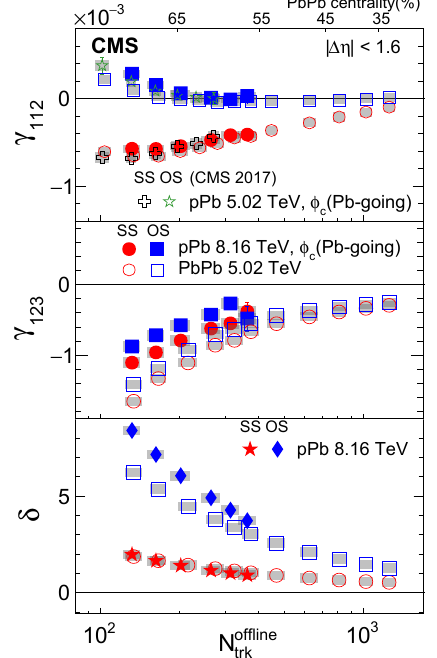
Figure 2. The SS and OS three-particle correlators, γ 112 (upper) and γ 123 (middle), and two-particle correlator, δ (lower), averaged over < 1 . 6 as a function of N o ffl ine ∆ η = 8 . 16 TeV and PbPb in pPb collisions at √ s trk NN | | collisions at 5.02 TeV [14]. The SS and OS two-particle correlators are denoted by di ff erent markers for pPb collisions. The results of γ 112 for pPb collisions at 5.02 TeV from CMS Collaboration (CMS 2017 [13]), are also shown for comparison. Statistical and systematic uncertainties are indicated by the error bars and shaded regions,